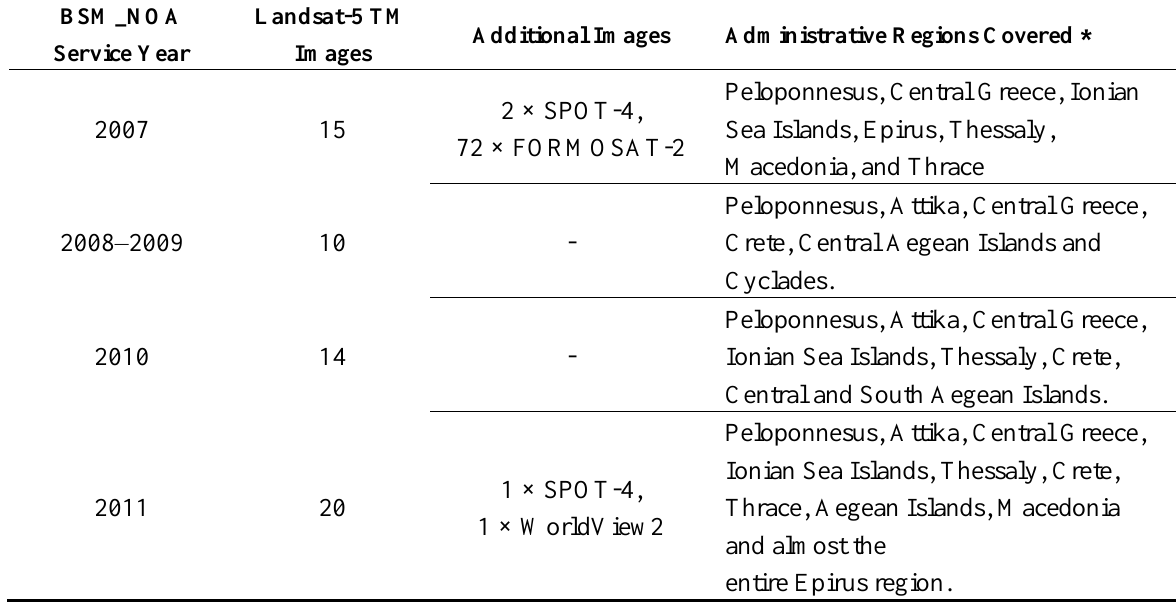
Table 1. Satellite imagery used for the annual national scale burnt-area mapping (BSM_NOA service delivery) for the years